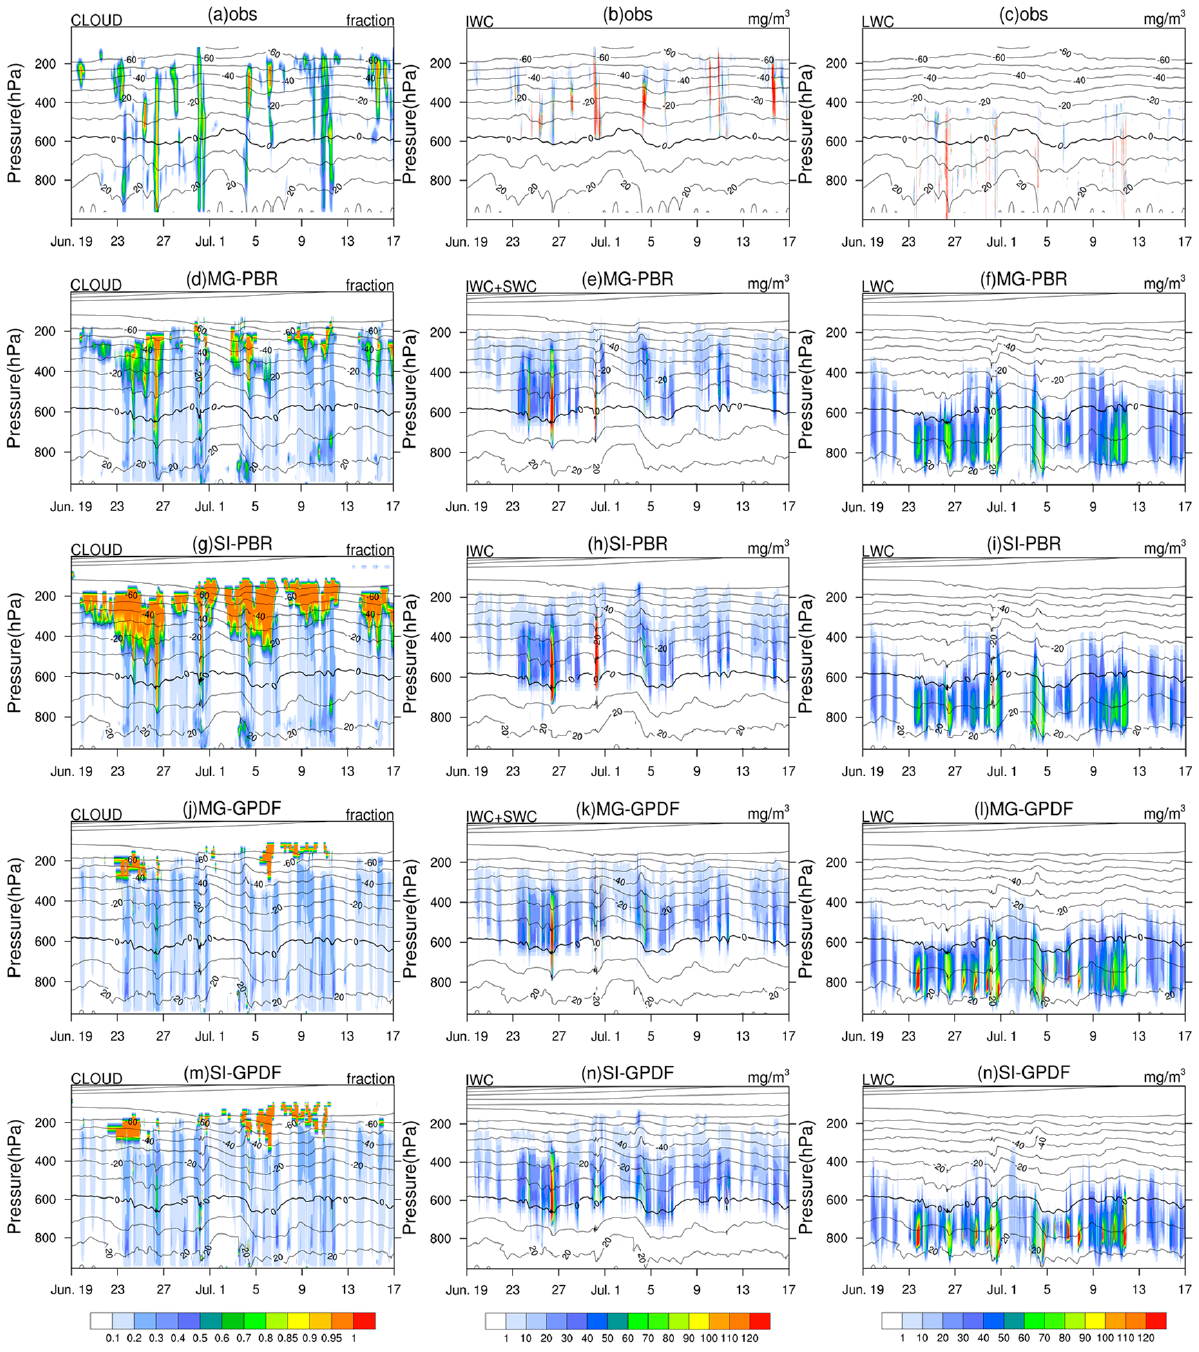
Figure 5. Temporal-vertical plot of cloud fraction (left), ice water content (middle column) and liquid water content (right) in addition to the atmospheric temperature (solid, °C) in the MG-PBR ( d – f ), SI-PBR ( g – i ), MG-GPDF ( j – l ), and SI-GPDF ( m , n , o ) simulation of the ARM97 in comparison with the observations and retrievals ( a – c ). The melting level is marked with bold lines in the middle panels.